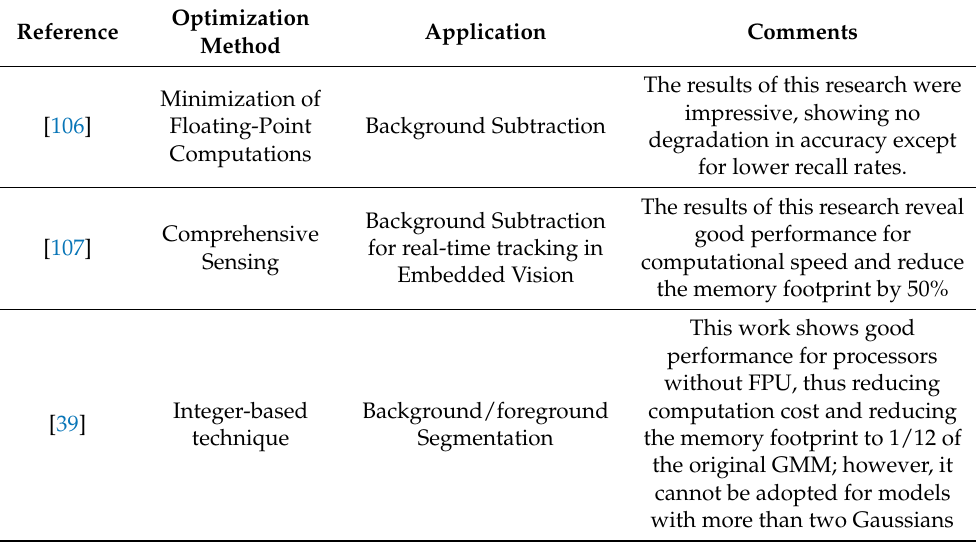
Table 8. Some GMM Optimization